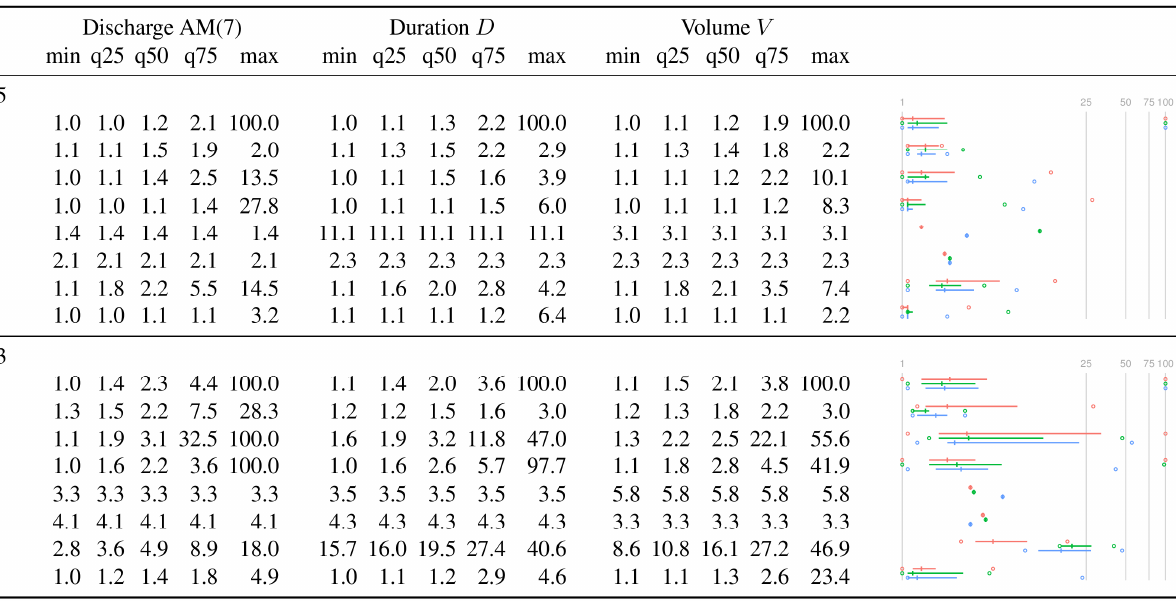
Table A3. Statistical summary of low flow and streamflow drought characteristics of stations with predominant winter seasonality: 2015 (top) and 2003 (bottom). Symbols and legend are those of Table